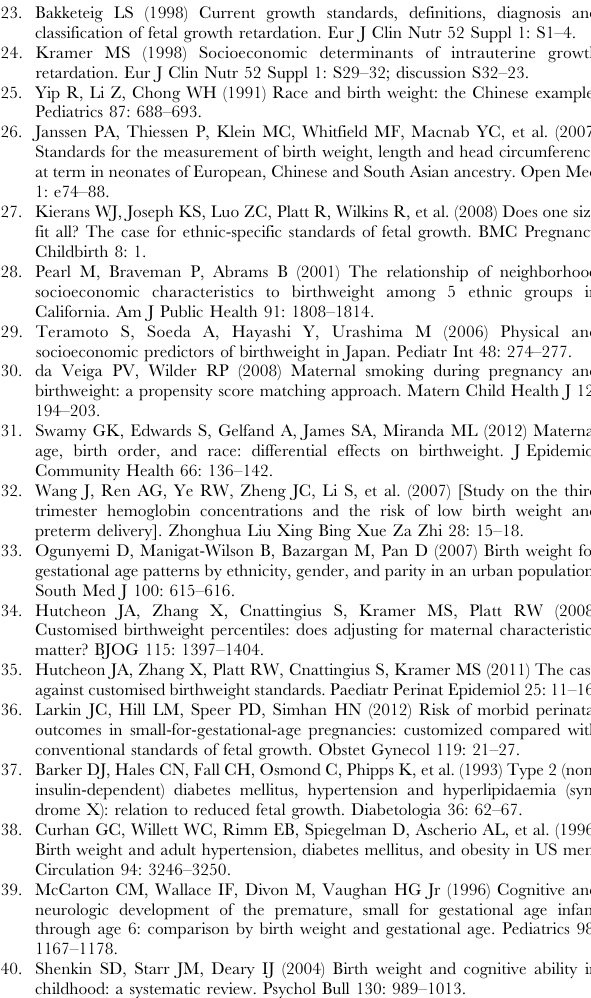
Table S1 Linear regression analysis on the relationship between birth weight and maternal/infant characteris- tics. Table S2 Smoothed birth weight percentiles for Han Chinese infants by gender during